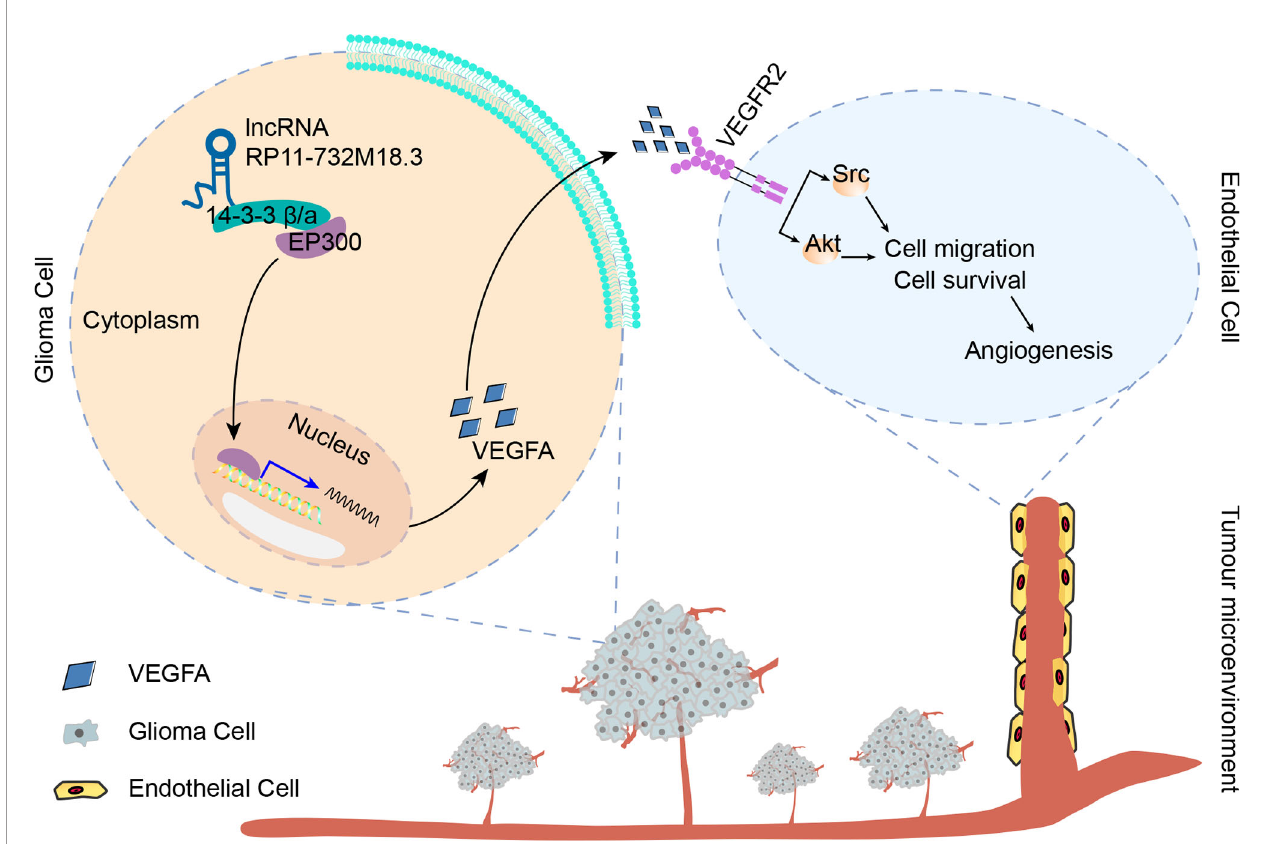
FIGURE 7 | lncRNA-RP11-732M18.3 promotes glioma angiogenesis. lncRNA-RP11-732M18.3 promotes the expression and nuclear translocation of EP300, which upregulates VEGFA and facilitates the activation of VEGFA downstream signaling pathways in ECs, promoting glioma